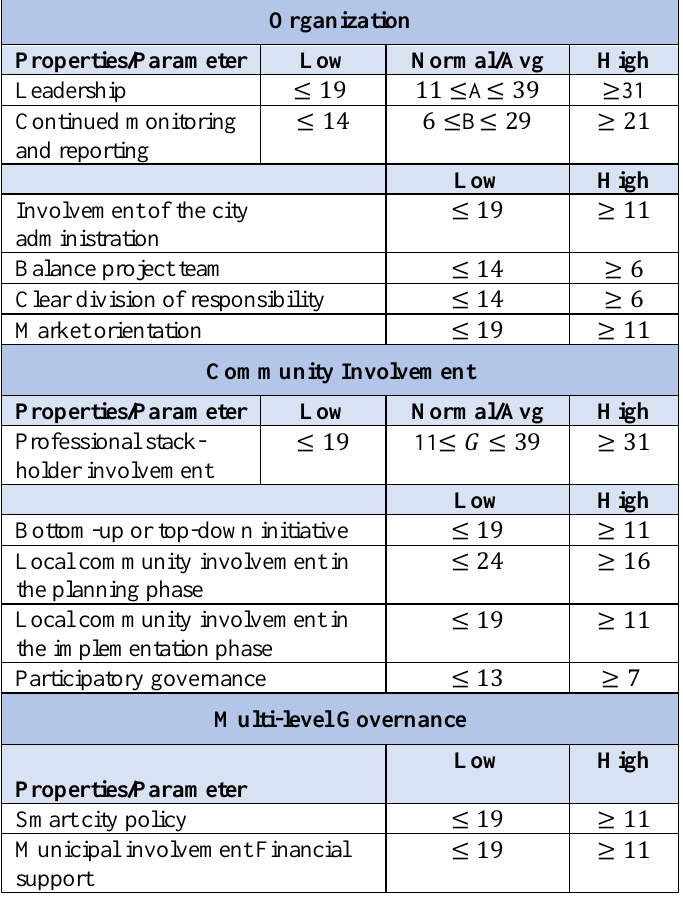
Table 3 . FIS Input/output Variables of Organization with Graphical & Mathematical representation of Proposed Methodology